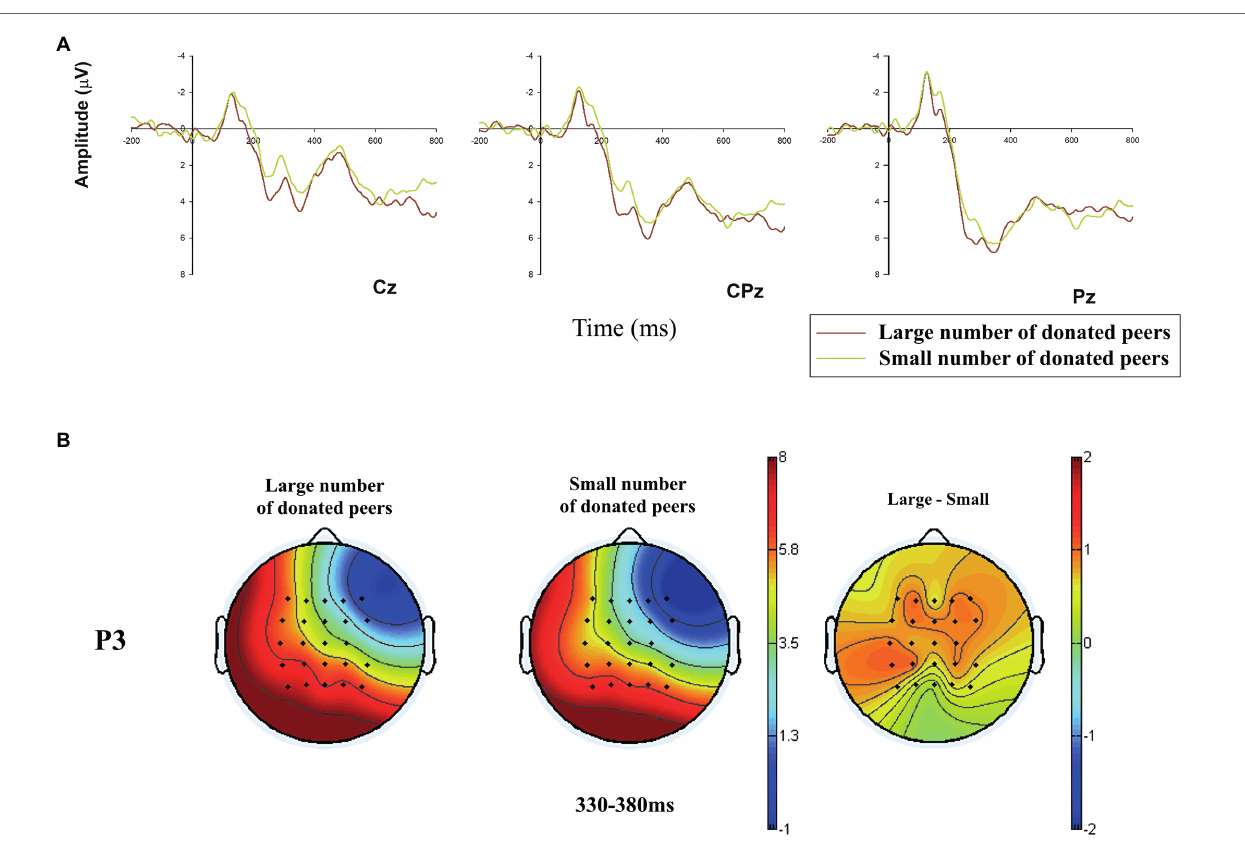
FIGURE 5 | Grand-averaged event-related potential (ERP) waveforms of P3 in three electrodes of central-to-parietal brain region, and related brain topographies. (A) Demonstration of P3 amplitudes in the two conditions (large vs. small number of donated peers) in representative electrodes (Cz, CPz, and Pz); (B) The P3 brain topographies of the two conditions at the time window of 330–380